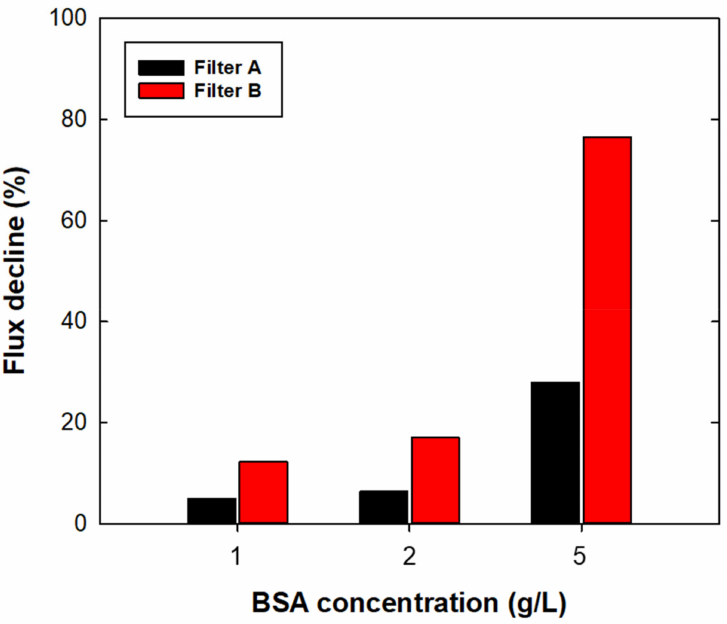
Figure 5. Flux decline (%) as a function of BSA concentration at 1, 2, and 5 g/L using filters A and B for the final fill. Values were obtained from BSA flux data at 10 min of operation time.